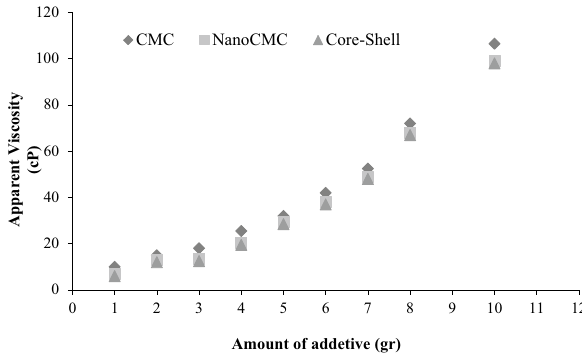
Fig. 15 Comparison of mud weight with bulk CMC, nanoCMC and core–shell nanocomposite additives